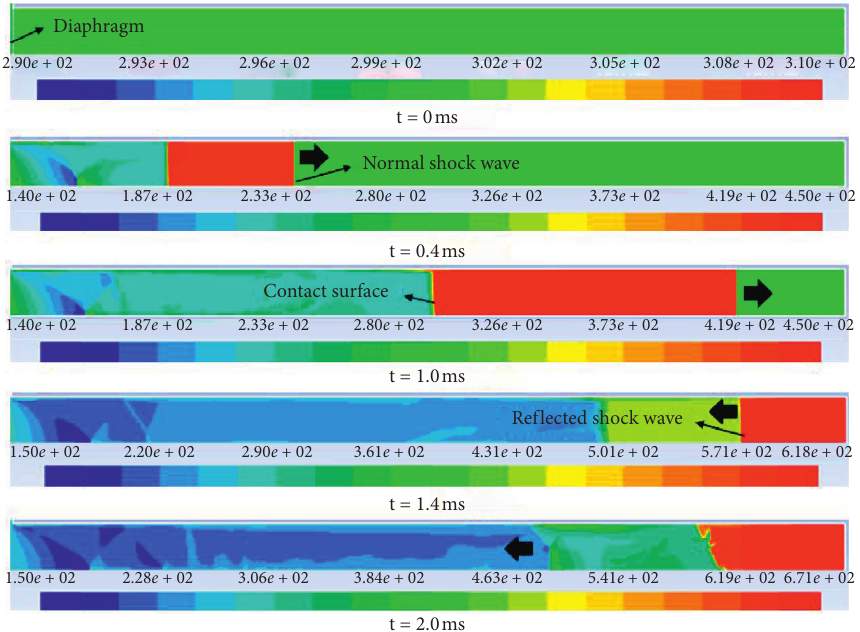
Figure 8: Temperature contours inside the driven section from numerical